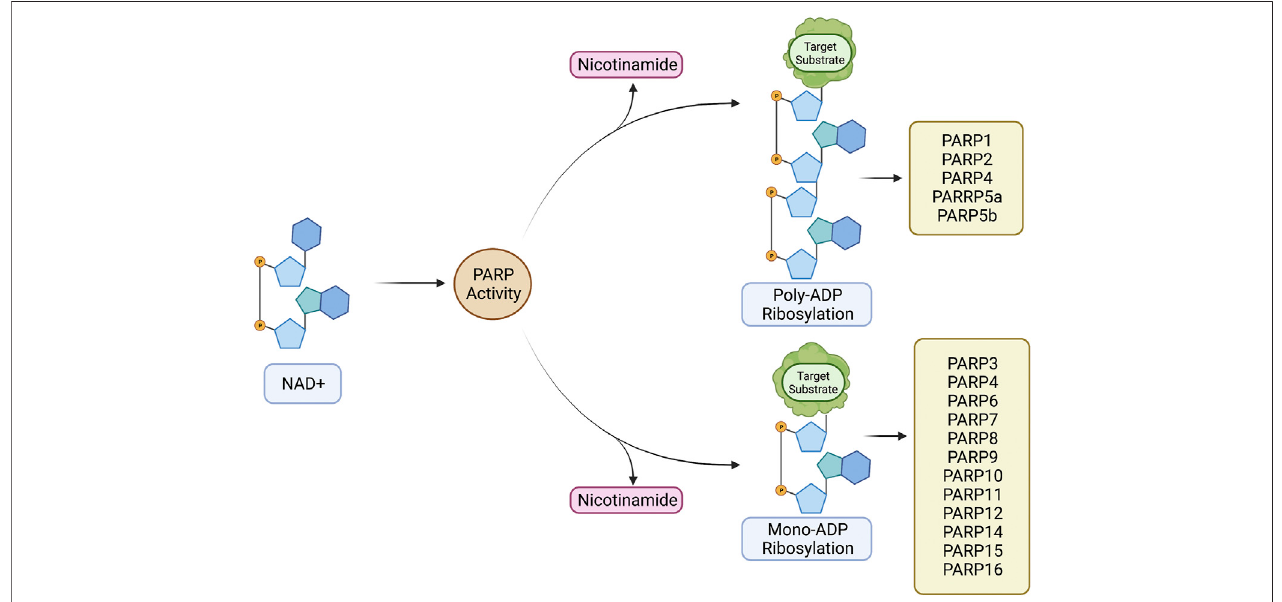
FIGURE 2 | PARP family-dependent poly and mono ADP ribosylation. These processes comprise conversion of NAD+ to a ribosylation modi fi cation via PARP catalytic activity,producingnicotinamideasabiproduct.PARP1/2/4/5a/5bhavebeenexperimentallyshowntoproducepoly-ADPribosylationmodi fi cations.PARP3/4/ 6/7/8/9/10/11/12/14/15/16 have been experimentally shown to produce mono-ADP ribosylation modi fi cations. Created with BioRender.com.